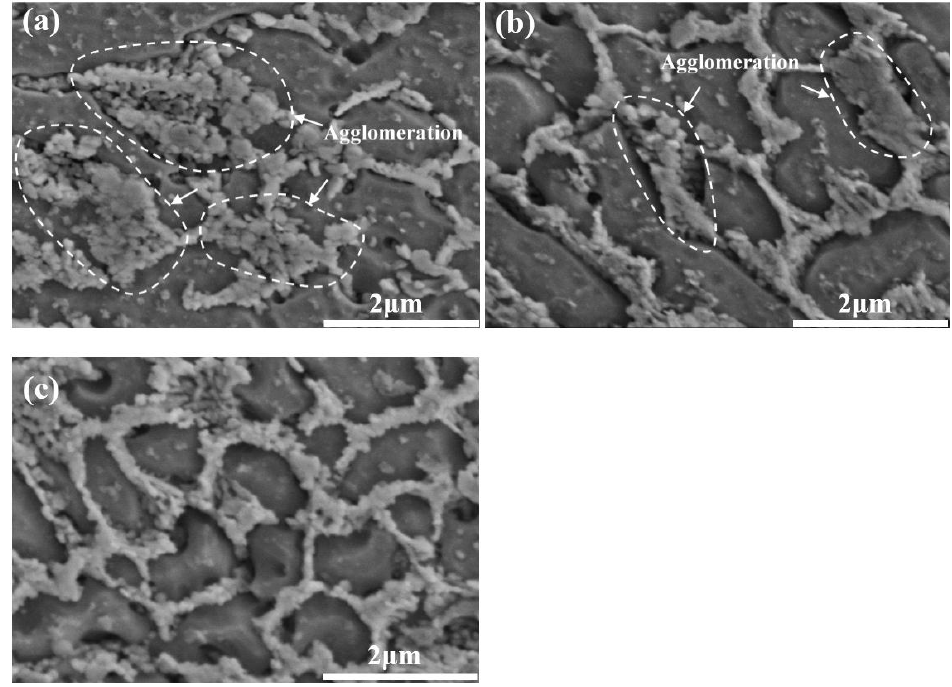
Figure 3. FE-SEM images of the microstructures of SLM-processed composites at 100 W, 400 mm/s ( a ); 150 W, 400 mm/s ( b ); 200 W, 400 mm/s ( c